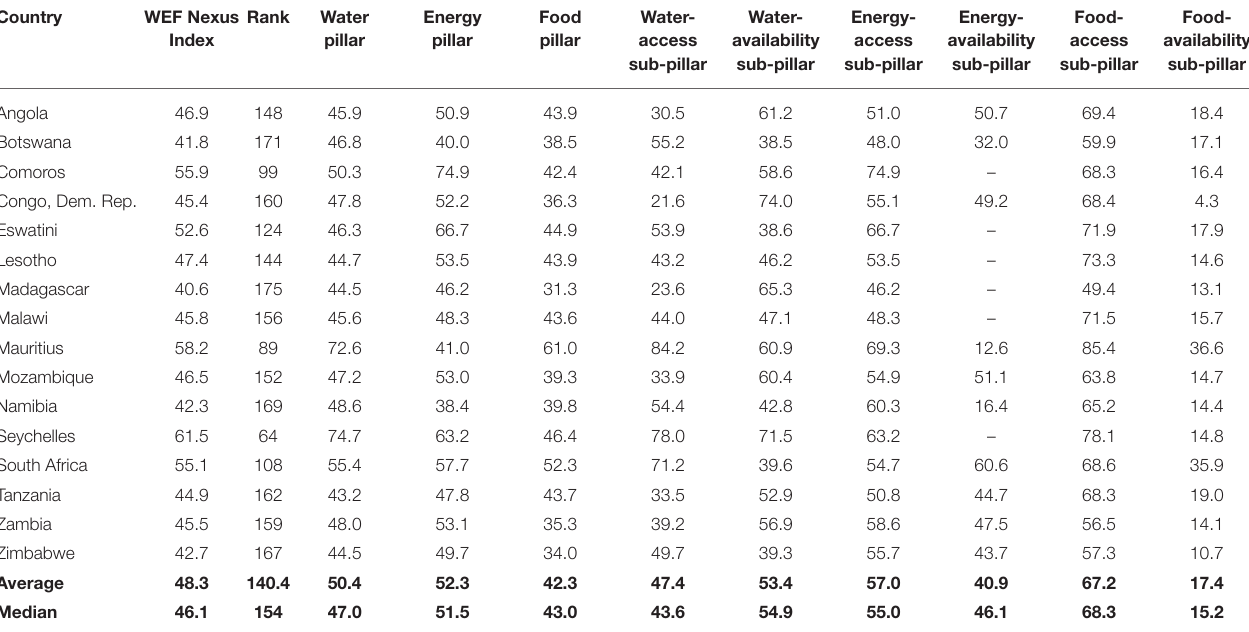
TABLE 1 | WEF Nexus Index, ranks, pillar and sub-pillar values for 16 SADC countries.